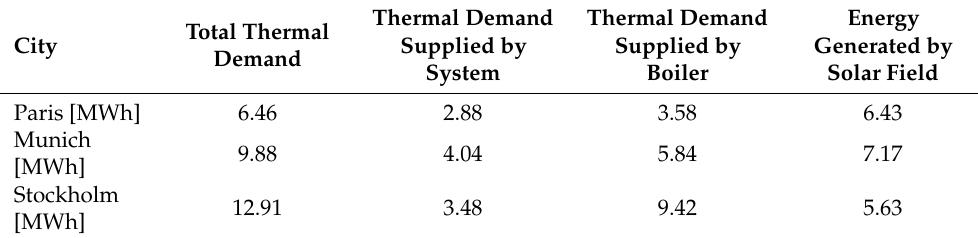
Table 10. Supplied energy demand and generated solar energy for each